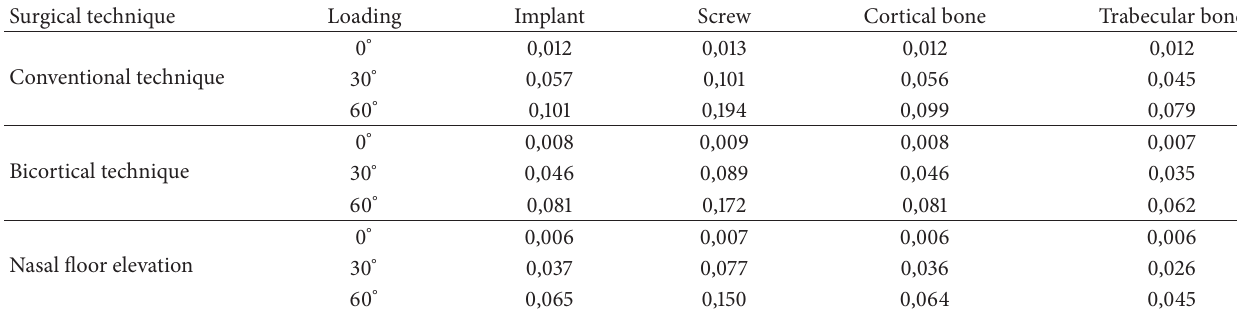
Table 4: Description values of models (in